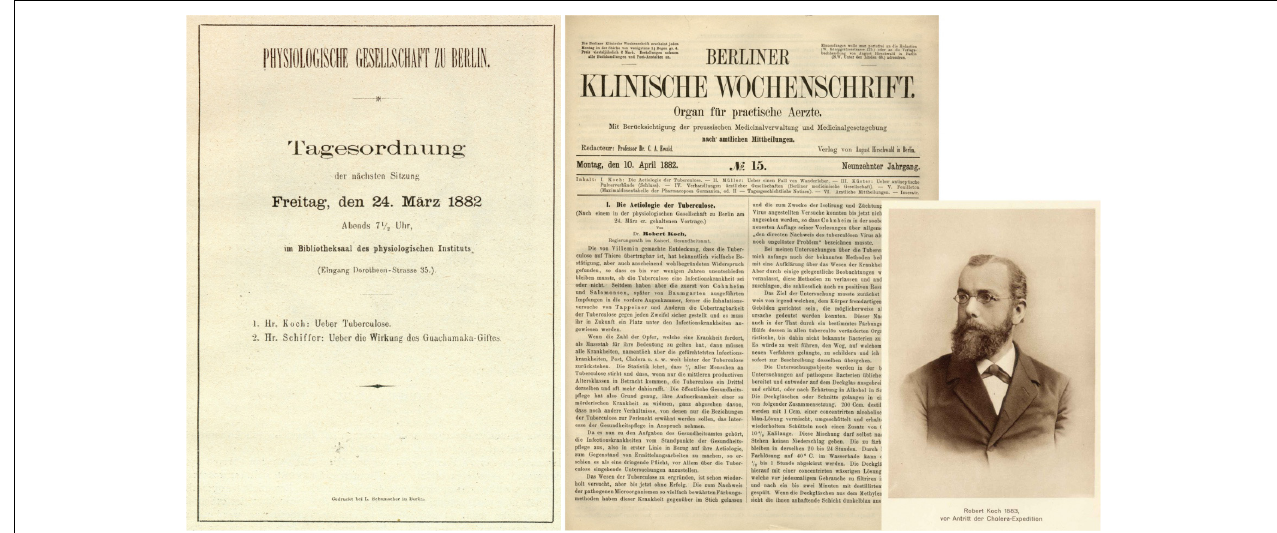
FIGURE 1 | Description of the etiology of TB by Robert Koch. Agenda of the meeting of the Physiological Society in Berlin, where Robert Koch for the first time presented his data on March 24, 1882 and first page of the publication on this topic in the Berlin Clinical Weekly, April 10, 1882 (Koch, 1882). Figure also includes photo of Robert Koch from 1883 (Kaufmann and Winau, 2005).